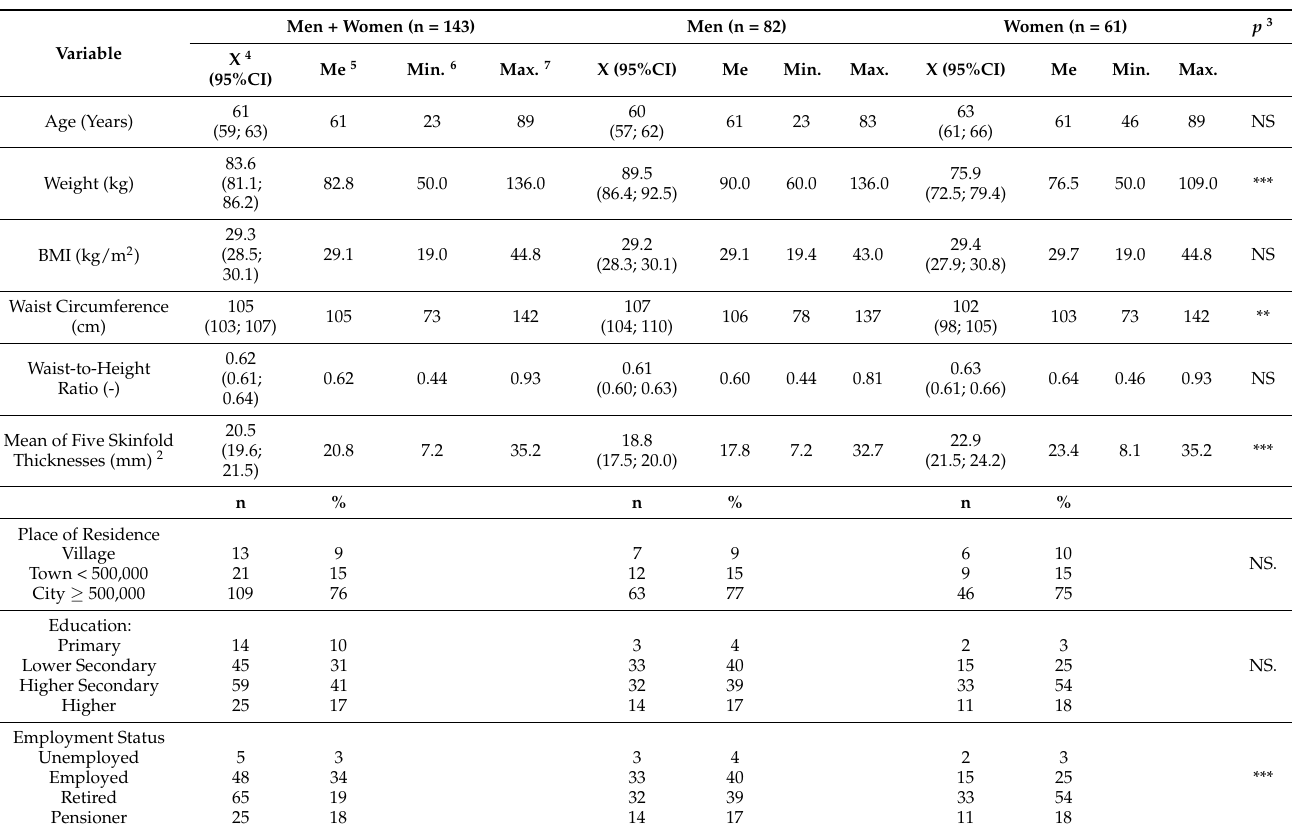
Table 1. Sample characteristics 1